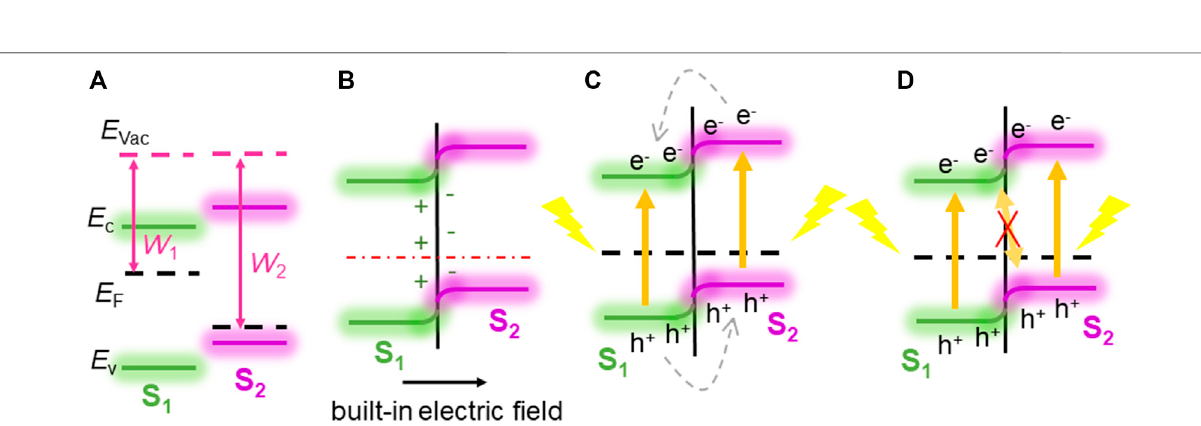
Frontiers in Chemistry |